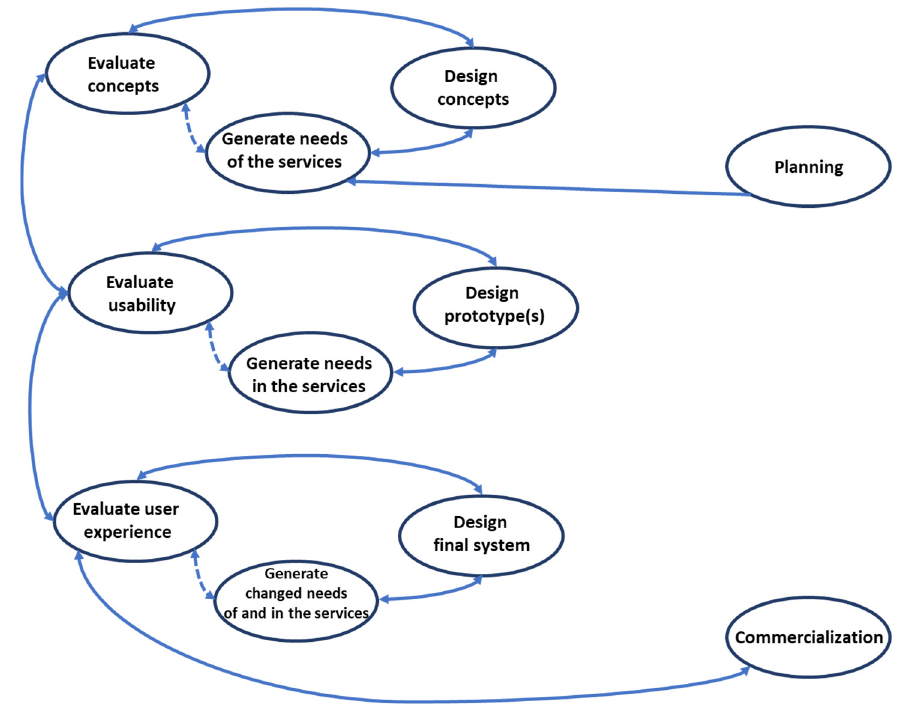
Figure 3. The in-system loop approach of Living Labs.